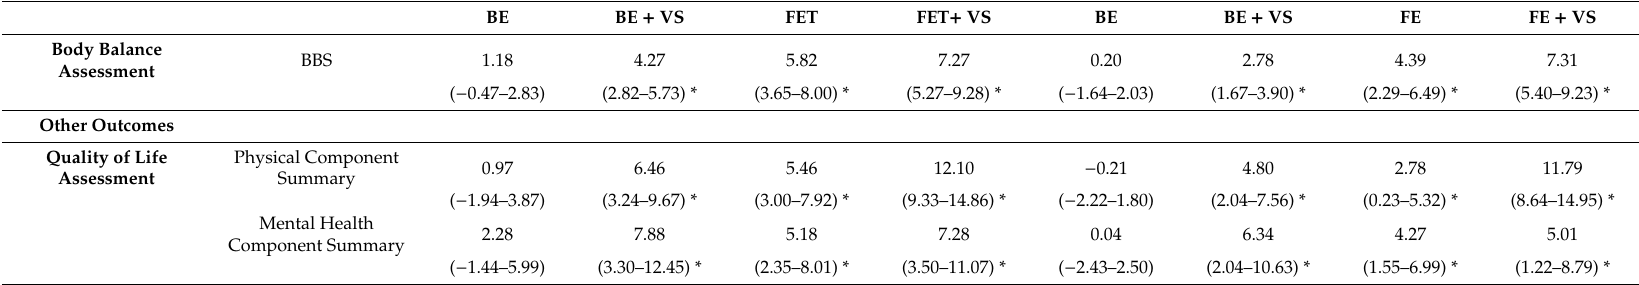
Table 2. Mean di ff erence scores for each group across